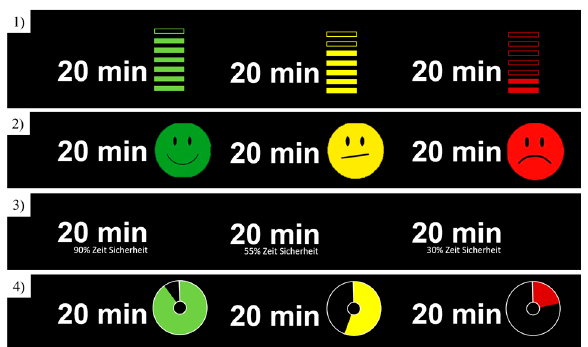
Figure 1. Concepts 1–4 with time budget (20 min) and confidence display.